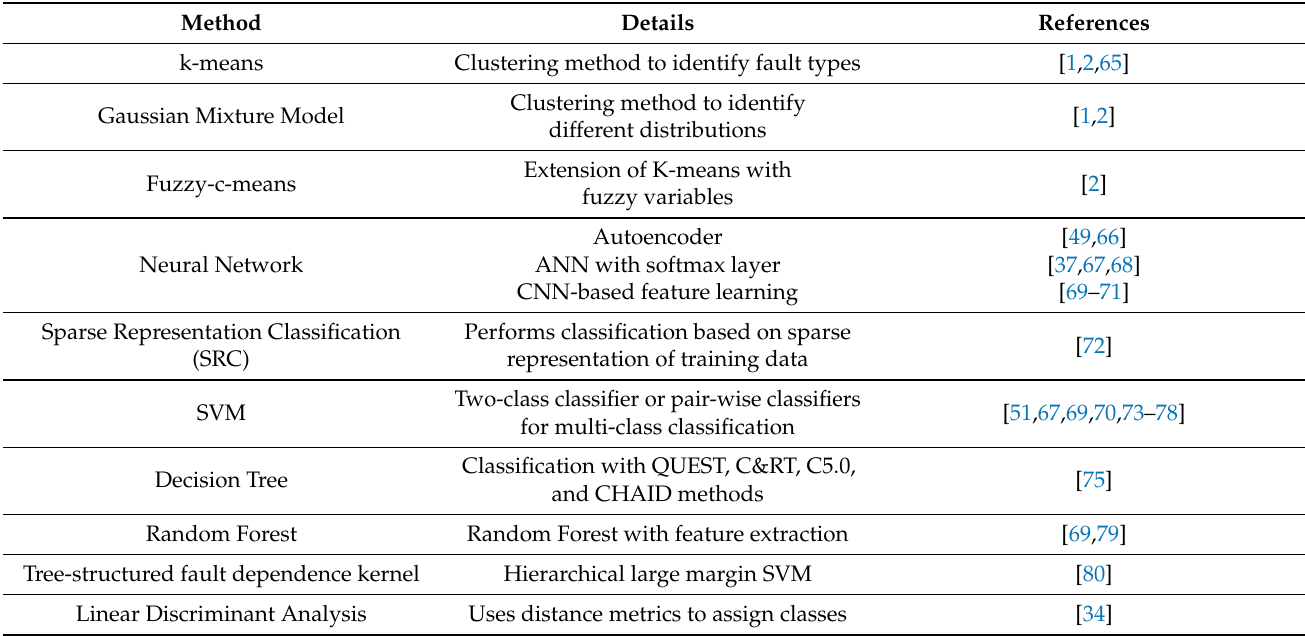
Table 2. Overview of used methods for fault classification with